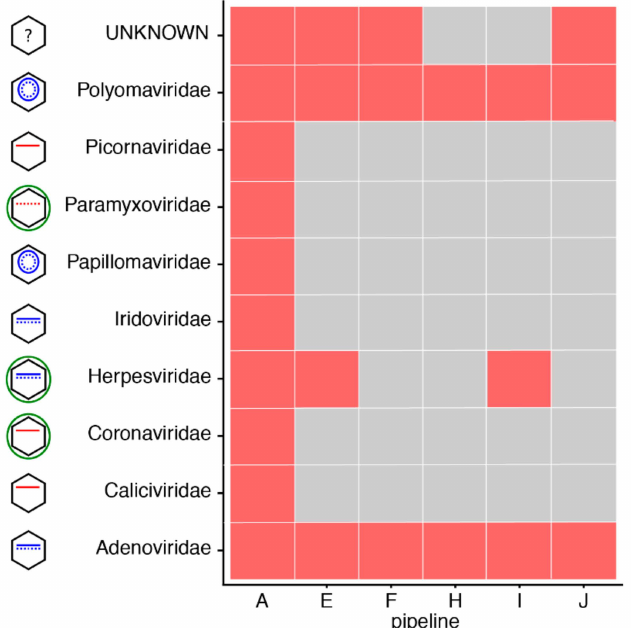
Figure 5. False positives identified by each pipeline in the negative sample of increment 2 (NIBSC negative control), when using the SIB common database. In order to compare results across the pipelines, we only show the family to which the false positive viruses identified by each pipeline belong (in red). The pictogram at the left of the family name gives an indication of the characteristics of the virus (envelope (green), DNA (blue; single or double stranded, linear or circular) or RNA (red, negative stranded if dotted line). Note that pipeline C is absent as it only returned results using its own in-house database, and not with the SIB common